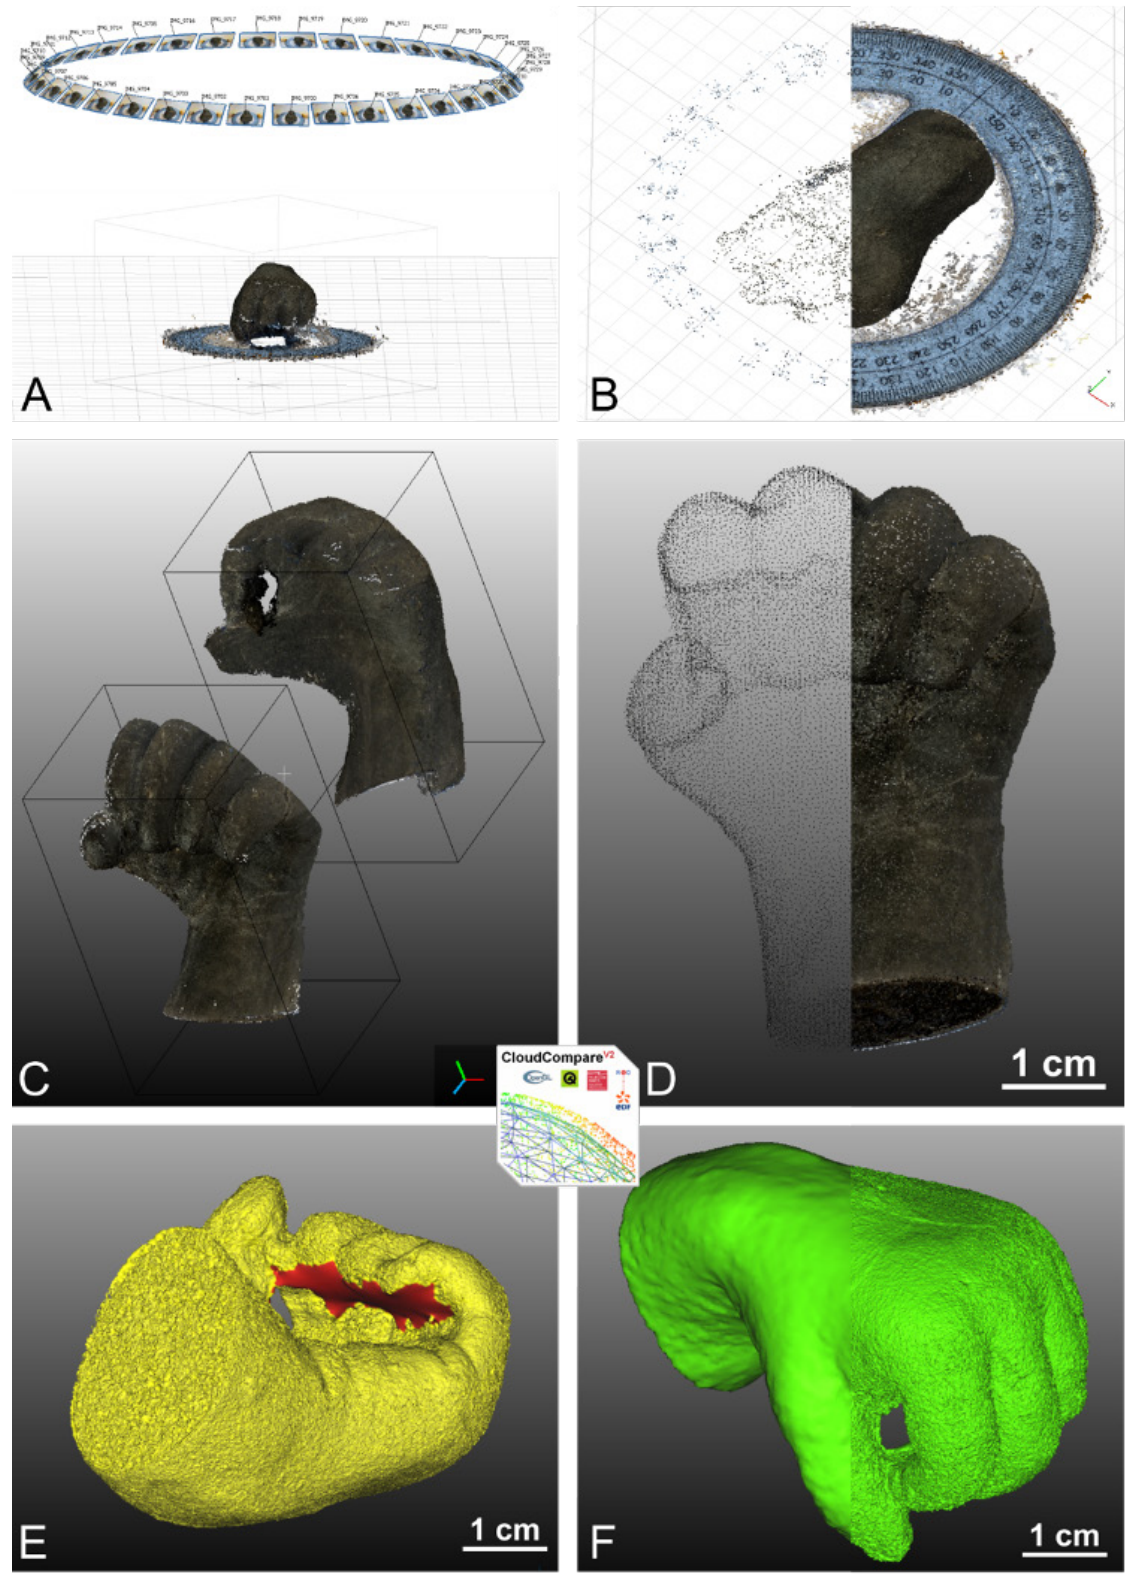
Figure A1: [A] Photo location and dense point cloud in Agisoft Metashape . [B] Tie points (feature points) as sparse point cloud (left), dense point cloud (right) in Agisoft Metashape . [C] Upper and lower point cloud before merging in CloudCompare . [D] Subsampled point cloud (left) with ~10 % of the number of points from the original (right). [E] Red highlights the parts with strong interpolation due to no points/no photo coverage. [F] Difference in roughness of the 3D models (mesh) originating from the subsampled point cloud (left) and the original point cloud